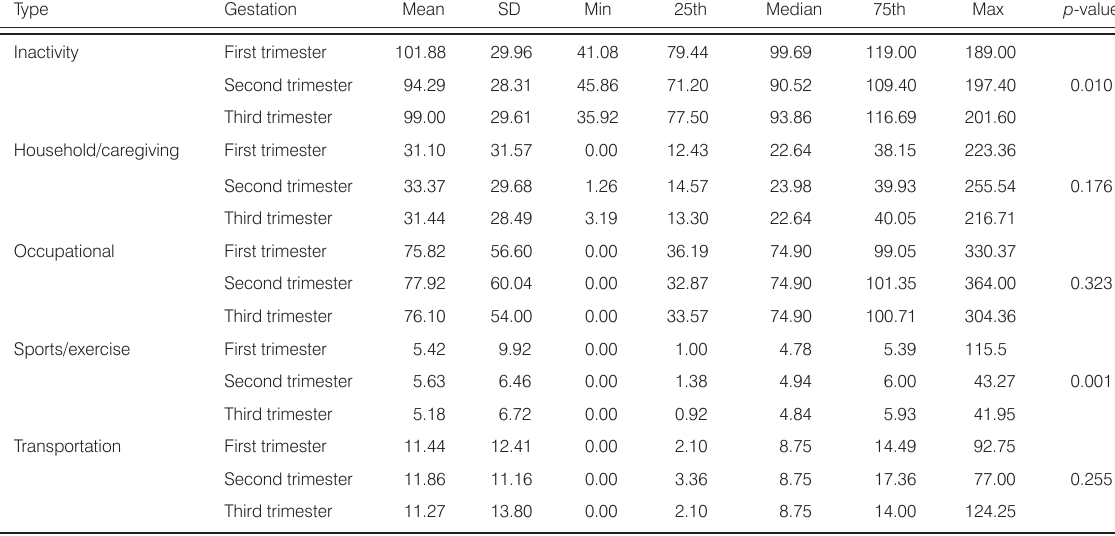
Table 4. Type scores of physical activity levels using the PPAQ among Chinese pregnant women (MET-hours/week).